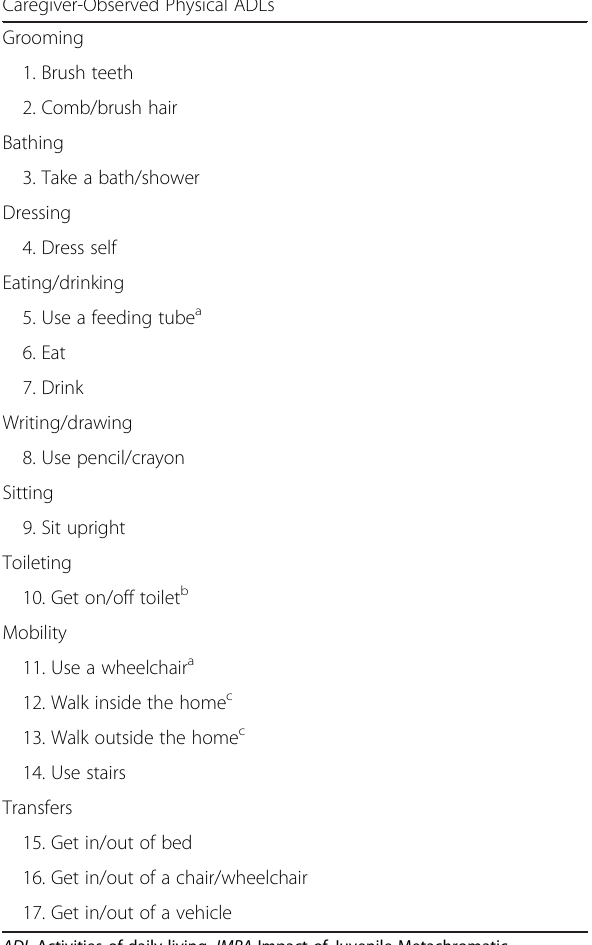
Table 3 Caregiver-Observed Activities by ADL Category Caregiver-Observed Physical